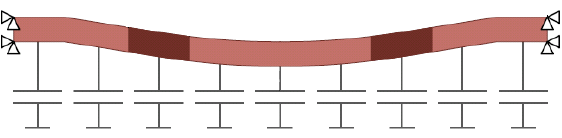
Figure 5. CMUT electrostatic gap segmentation. The electrostatic force is approximated by adding several parallel plate capacitors between the top and bottom